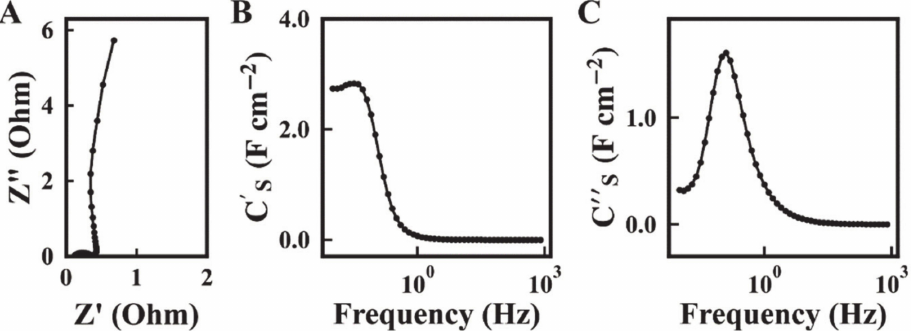
Figure 7. ( A ) Nyquist plot of complex impedance and ( B , C ) frequency dependences of ( B ) C S (cid:48) ( C ) C S (cid:48)(cid:48) for Mn 3 O 4 -MWCNT